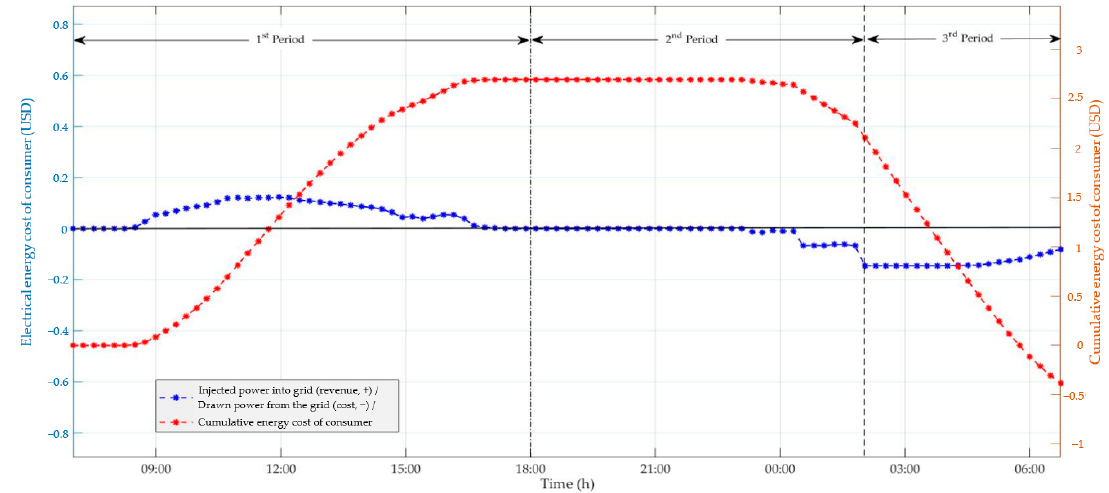
Figure 7. The charging (+)/discharging ( − ) and stored energy for the ESS in each time slot.